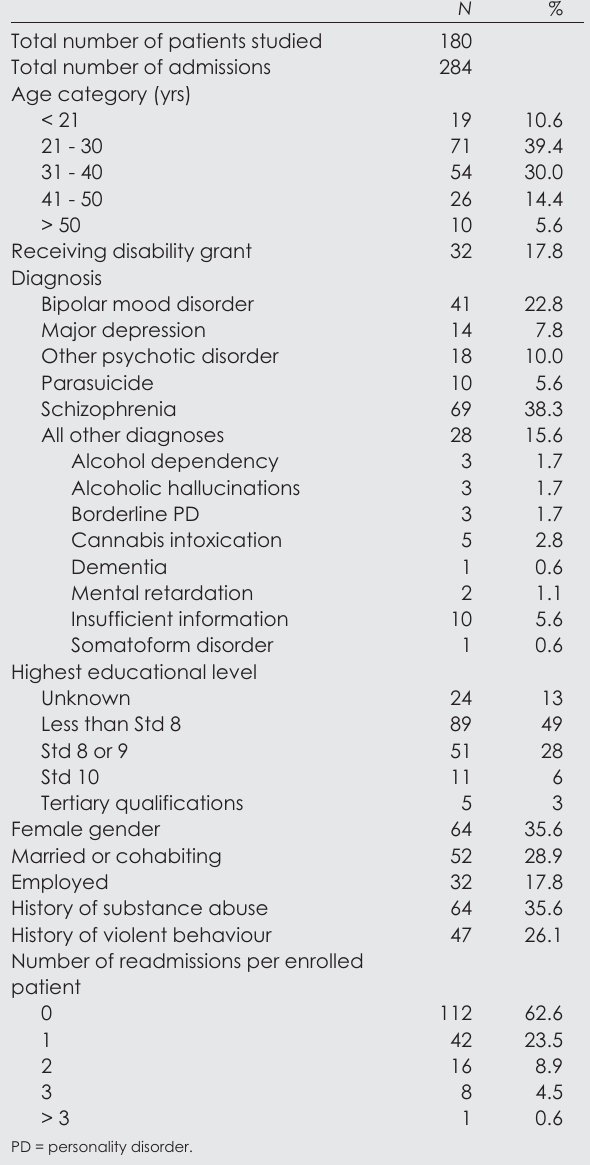
Table I. Descriptive statistics for patients